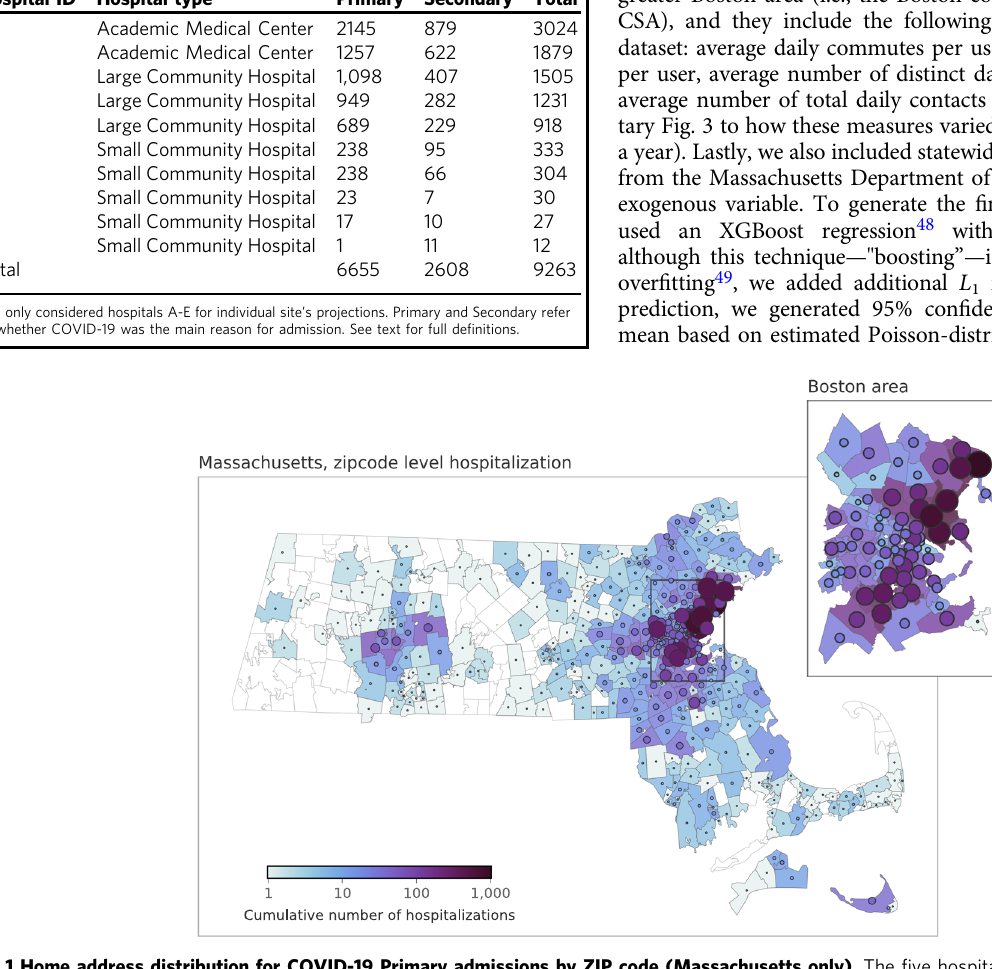
Fig. 1 Home address distribution for COVID-19 Primary admissions by ZIP code (Massachusetts only). The fi ve hospitals in this study service a relatively large region around the greater Boston area. Color and size of markers indicate cumulative hospital admissions within ZIP codes.